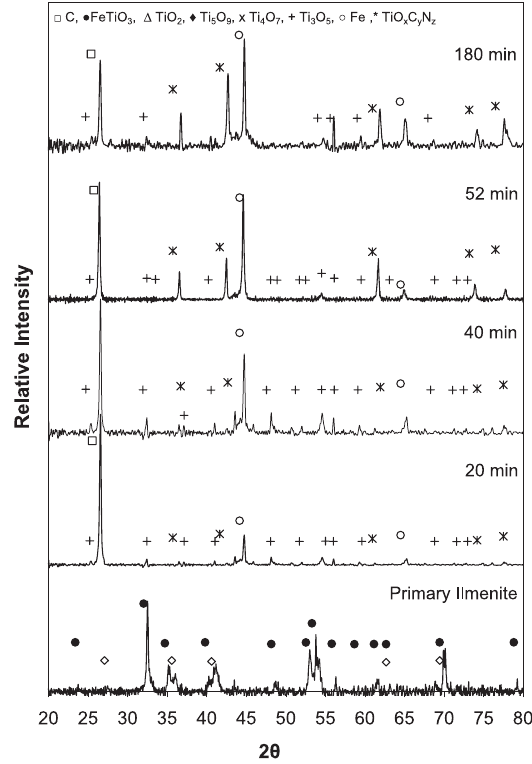
Fig. 7: XRD patterns of primary ilmenite in the progress of reduction in the H -N gas mixture at 1373 K. 2 2